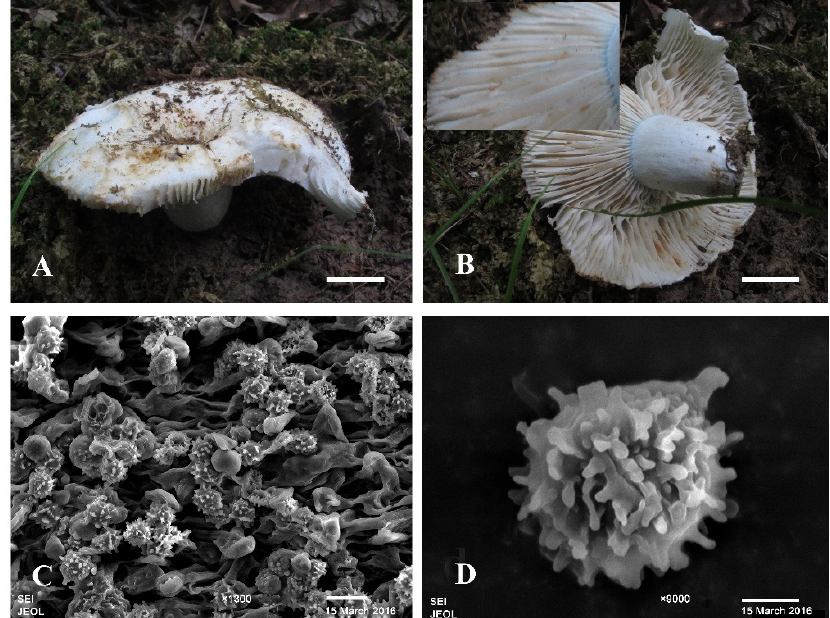
Figure 5. Basidiomata and microscopic structures of Russula callainomarginis (drawn from the holo- type). ( A , B ) Basidiomata. ( C , D ) Basidiospores (SEM). Scale bars: ( A , B ) = 1.3 cm, ( C , D ) = 10 µ m.